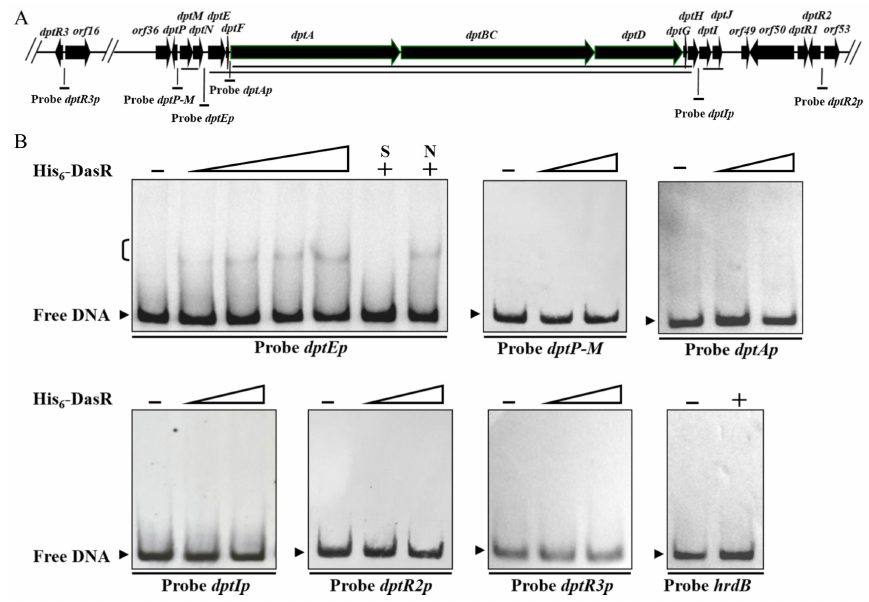
Figure 3. Binding of DasR to dptE -promoter region. ( A ) Promoter probes used for EMSAs (schematic). Long solid lines: transcriptional units. ( B ) EMSAs of interactions of His 6 -DasR with promoter probes of dpt genes. Negative control probe: hrdB . Concentrations of His 6 -DasR for probe dptEp : 1, 1.5, 3, and 4.5 µ M; for other dpt promoter probes: 1 and 4.5 µ M. Lanes –: EMSAs without His 6 -DasR.